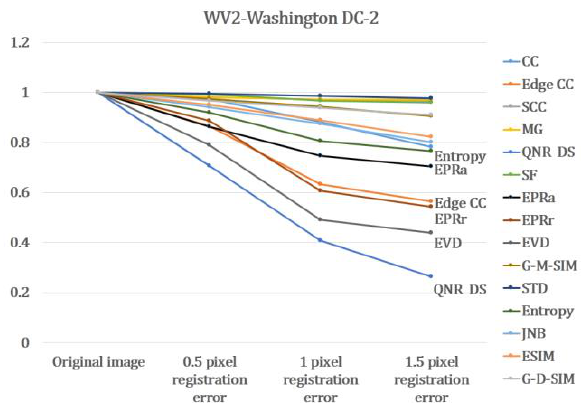
Figure 11. Comparative charts of metrics on data 3.